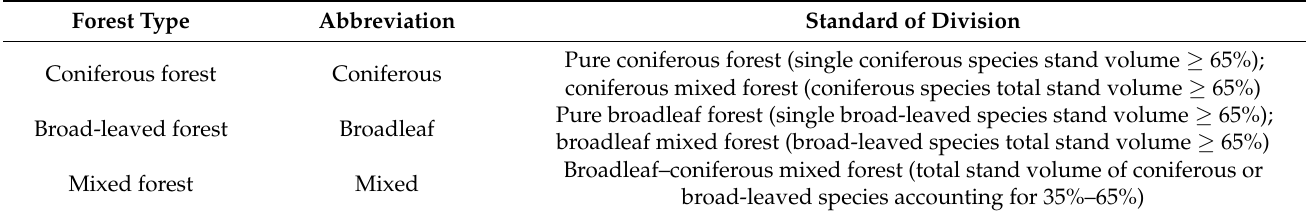
Table 2. Classification standard of forest types [23].